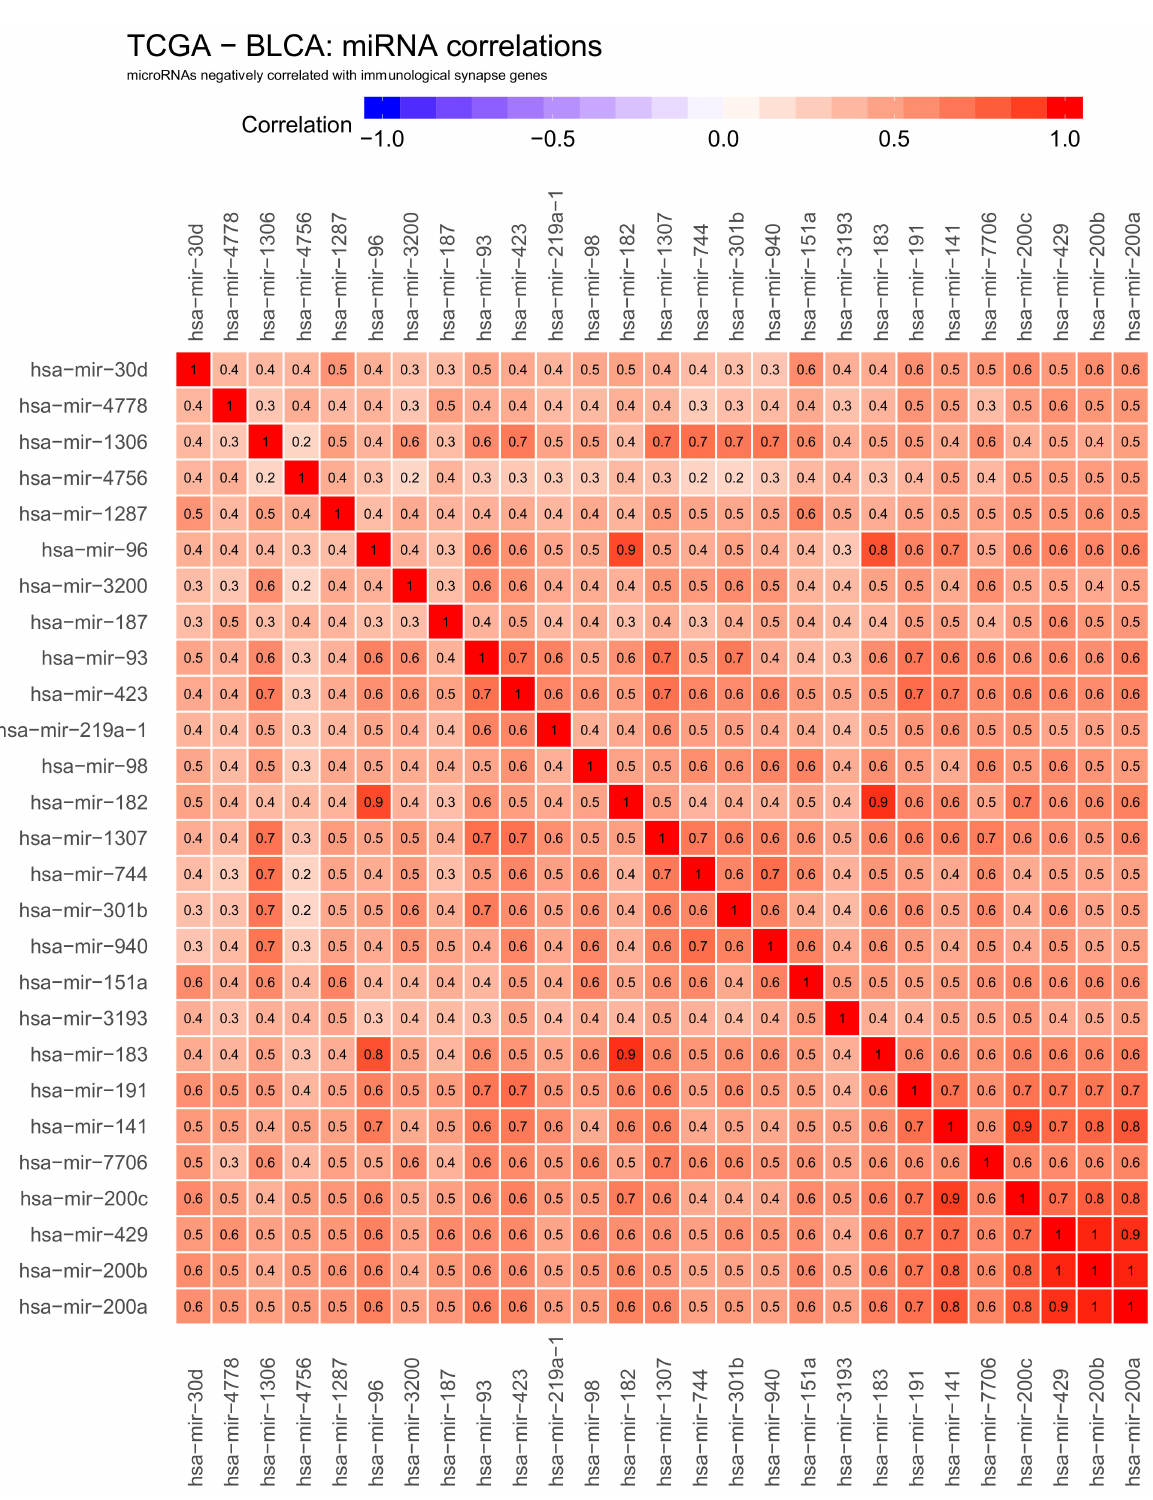
Figure 5. Heatmap showing correlations within miRNA hits negatively correlated to checkpoint genes. Positive correlations are shown in red, negative correlations are shown in blue. The numbers in heatmap tiles represent the correlation